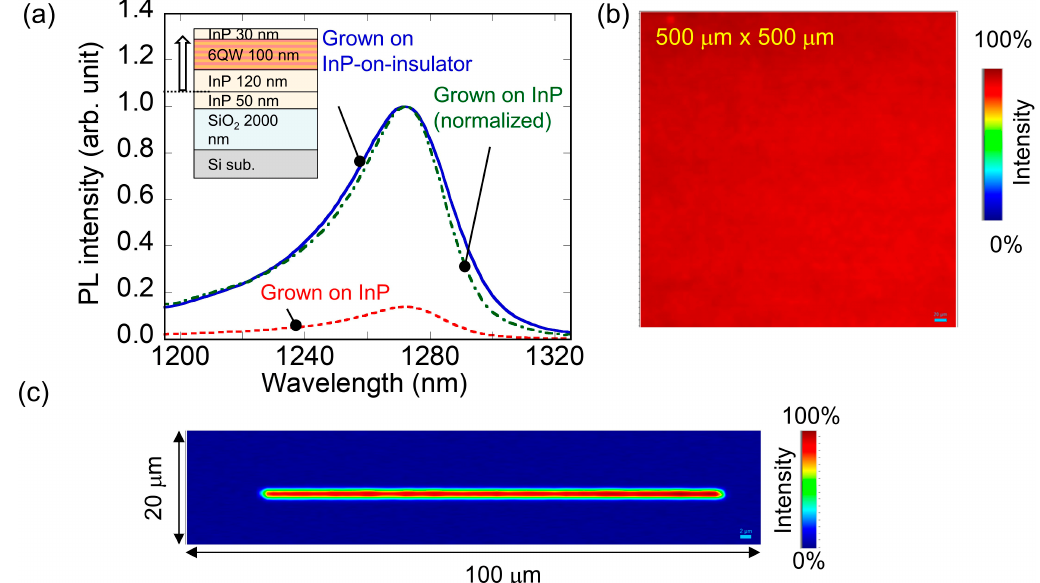
Figure 6. ( a ) PL spectra of indium ‐ gallium ‐ aluminum arsenide (InGaAlAs) MQW grown on InP ‐ on ‐ insulator substrate and same MQW grown on standard InP substrate; ( b ) PL ‐ intensity map for MQW grown on InP ‐ on ‐ insulator substrate measured with PL microscope; ( c ) PL intensity ‐ map for MQW ‐ BH after regrowth of InP layer.